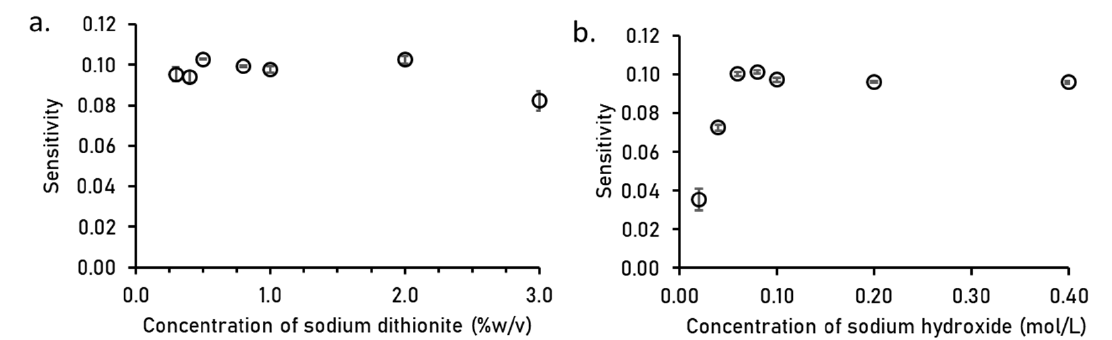
Figure 4. Effect of reagent concentrations of ( a ) Na 2 S 2 O 4 and ( b ) NaOH on paraquat sensitivity. Experimental conditions: 10.00 mL of standard paraquat, 0.50 mL of color-forming reagent solution, 1000 rpm of stirring speed, and 30 s of stirring time.